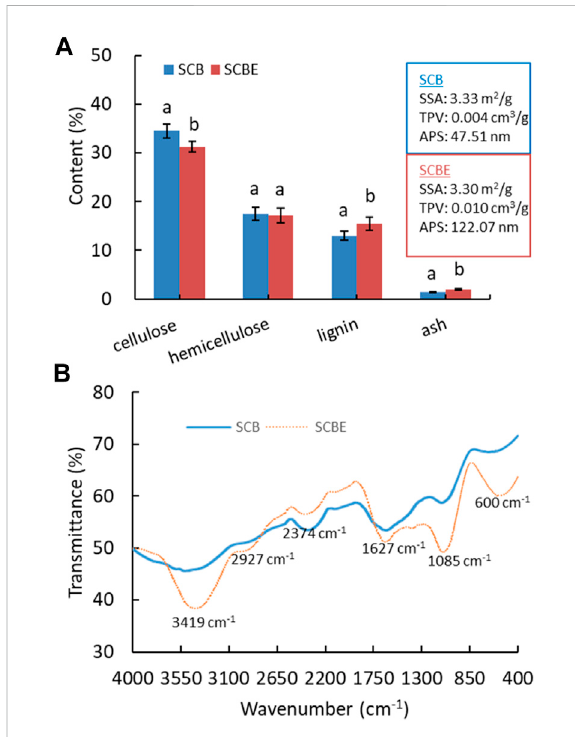
FIGURE 4 Chemical composition (A) and FTIR spectra (B) of SCB